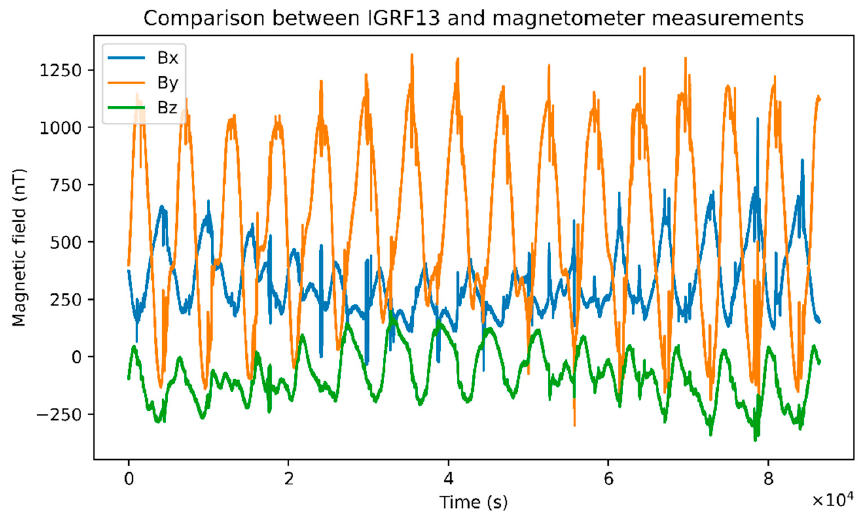
Figure 4. Comparison of GRACE-FO magnetometer measurements on 1 February 2020 with IGRF13.